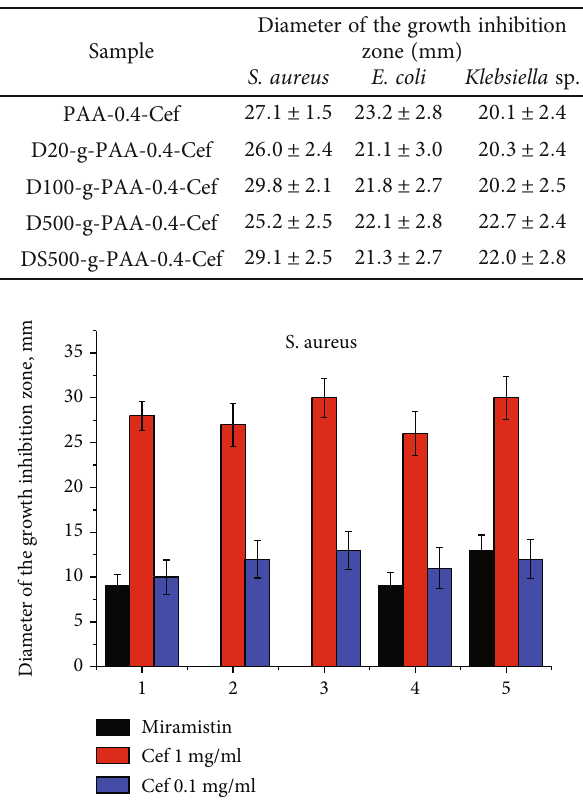
Figure 4: Activity of the antimicrobial hydrogels (1) PAA-0.4-Cef, (2) D20-g-PAA-0.4-Cef, (3) D100-g-PAA-0.4-Cef, (4) D500-g- PAA-0.4-Cef, and (5) DS500-g-PAA-0.4-Cef against S. aureus (black — miramistin 0.1mg/mL; blue — cefuroxime 0.1 mg/mL; red — cefuroxime 1mg/mL).